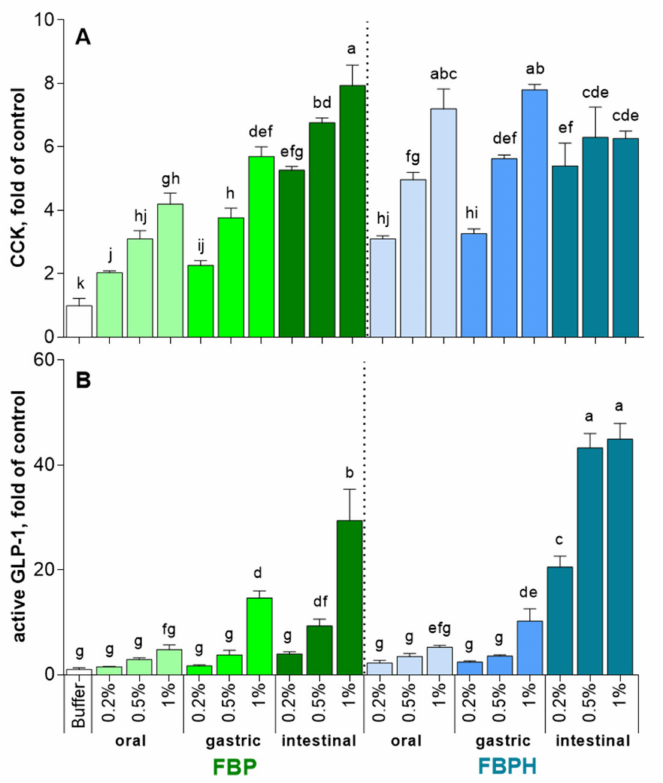
Figure 2. FBPH and FBP induction of intestinal hormones release during simulated GI digestion. The amounts of intestinal hormones released in STC-1 cells in the supernatants after 2 h of contact with the FBP and FBPH digests (2; 5 and 10 mg mL − 1 w / v ) were determined by radioimmunoassay for CCK ( A ) and active GLP-1 ( B ). Values are means ± SD and are expressed in fold of control (buffer). Means without a common letter within the same graph are significantly different ( p < 0.05) using one-way ANOVA following by Tukey post-hoc test for pairwise